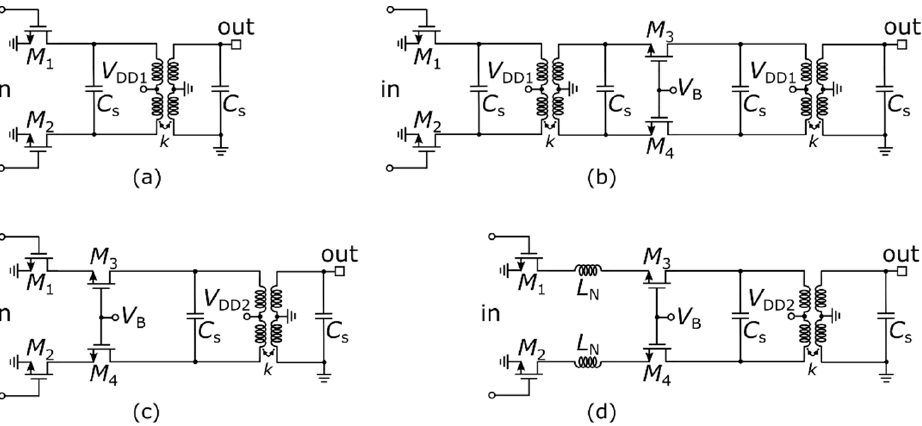
Figure 1. Mm-wave power stage topologies. ( a ) CS stage; ( b ) TBFC stage; ( c ) CAS stage; ( d ) enhanced CAS stage.